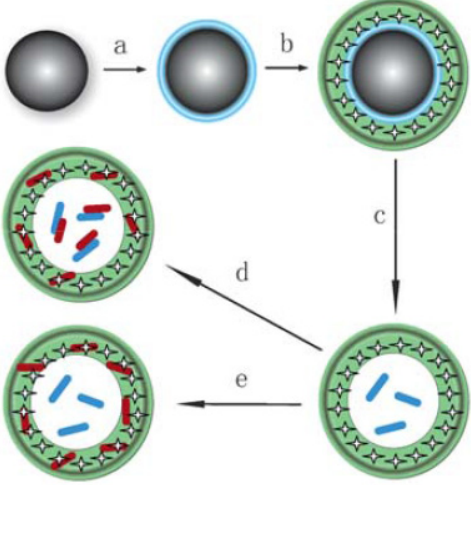
Figure 9. Preparation of ssDNA-containing LbL microcapsule and selective encapsulation of target ssDNA into the microcapsule through hybridization. ( a ) deposition of ssDNA on the core particle; ( b ) deposition of dendrimer film; ( c ) removal of core material; ( d ) encapsulation of target ssDNA into the microcapsule; and ( e ) adsorption of mismatch ssDNA. Reprinted with permission from Zhang et al. [135] Copyright (2010) The Royal Society of